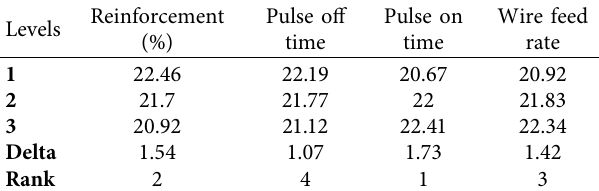
Table 7: Response table for